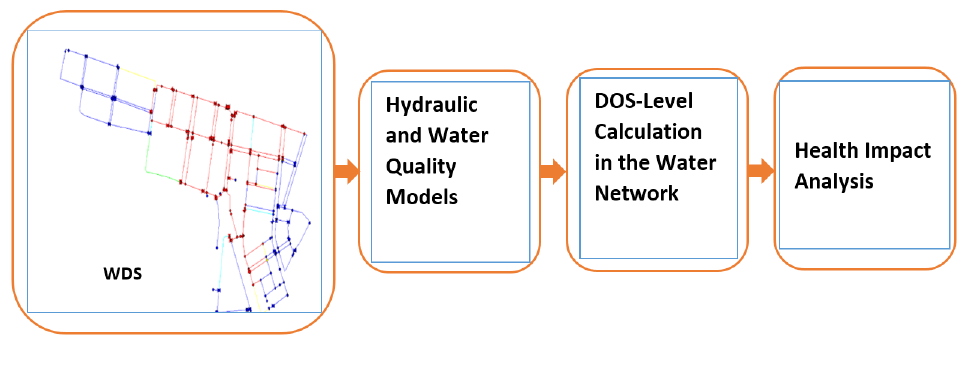
Figure 2. The proposed model of health